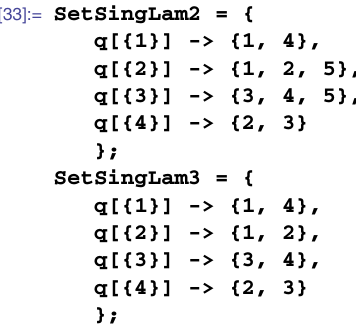
where i in q [{ i }] corresponds to the i -th cusp in the topology and is defined according to the lines that connect this cusp (red labels in Fig. 3 (left)). Also, in order to pictorially see that the edges defined in SetSingLam are properly written, we implement the routine PlotTop that displays the topology under consideration, In[31]:= PlotTop[SetSingLam] producing a figure in a Mathematica notebook, as the one shown in Fig. 4